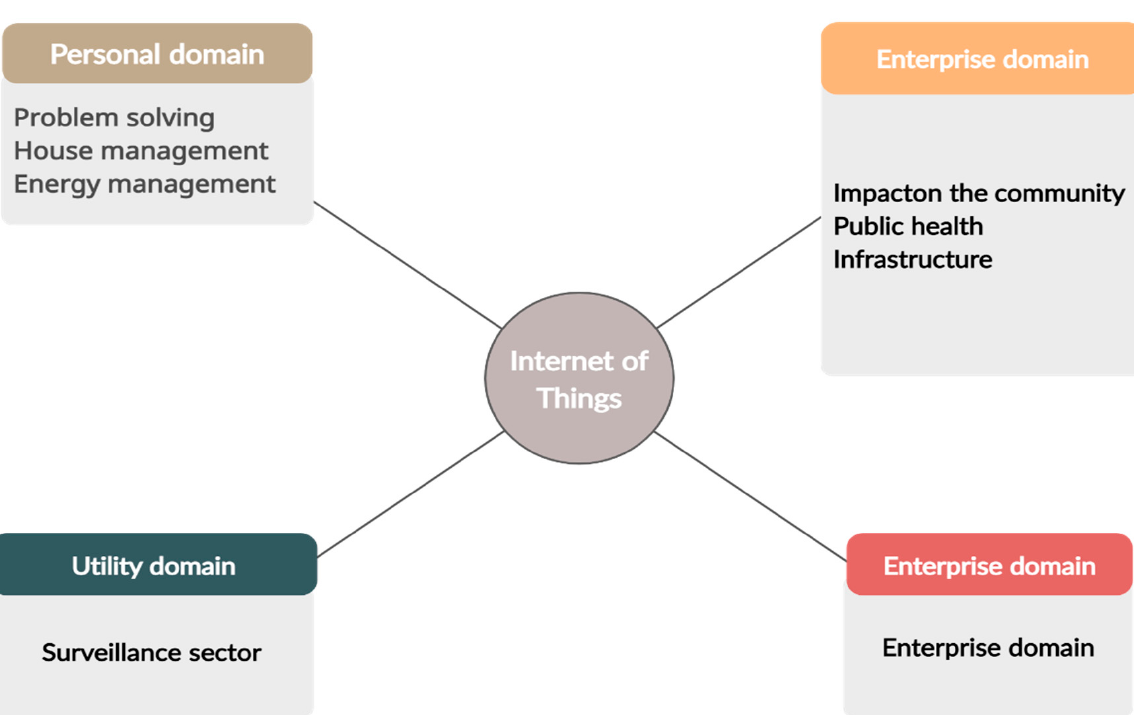
Figure 2. The advantages of IoT application in various fields.